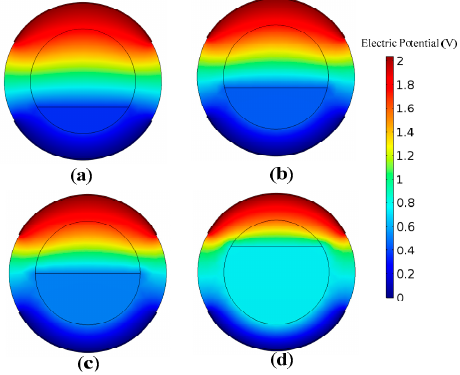
Figure 4. Cross section potential distribution of the CCS calculated by COMSOL Multiphysics. ( a ) H w = 20%; ( b ) H w = 30%; ( c ) H w = 50%; ( d ) H w = 80%.